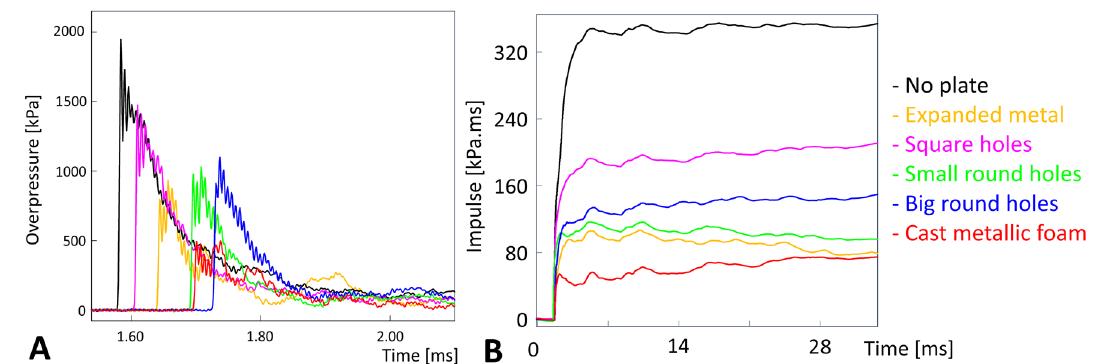
Fig. 10 Reflected overpressure ( A ) and impulse ( B ) measured on the wall positioned 50 mm behind the plate for all types of plate. The figure also shows the results of a reference test, which was performed without plate, as well as the results obtained with the cast metallic